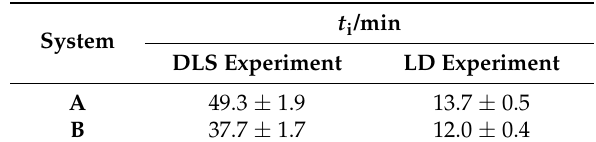
Figure 1. Representative pH vs. time curves of amorphous calcium phosphate (ACP) formation and transformation in the precipitation systems A ( c (CaCl 2 · 2H 2 O) = c (Na 2 HPO 4 ) = 3.5 mmol dm − 3 ) and B ( c (CaCl 2 · 2H 2 O) = c (Na 2 HPO 4 ) = 4 mmol dm − 3 ), at conditions corresponding to DLS and LD measurements, without and with mechanical stirring, respectively. pH init = 7.4, ϑ = 25.0 ± 0.1 °C. Table 1. Average induction times ( t i ) obtained from pH vs. time ( t ) curves in the precipitation systems A ( c (CaCl 2 · 2H 2 O) = c (Na 2 HPO 4 ) = 3.5 mmol dm − 3 ) and B ( c (CaCl 2 · 2H 2 O) = c (Na 2 HPO 4 ) = 4 mmol dm − 3 ), at conditions corresponding to DLS and LD measurements, without and with mechanical stirring. pH init = 7.4, ϑ = 25.0 ± 0.1 °C.